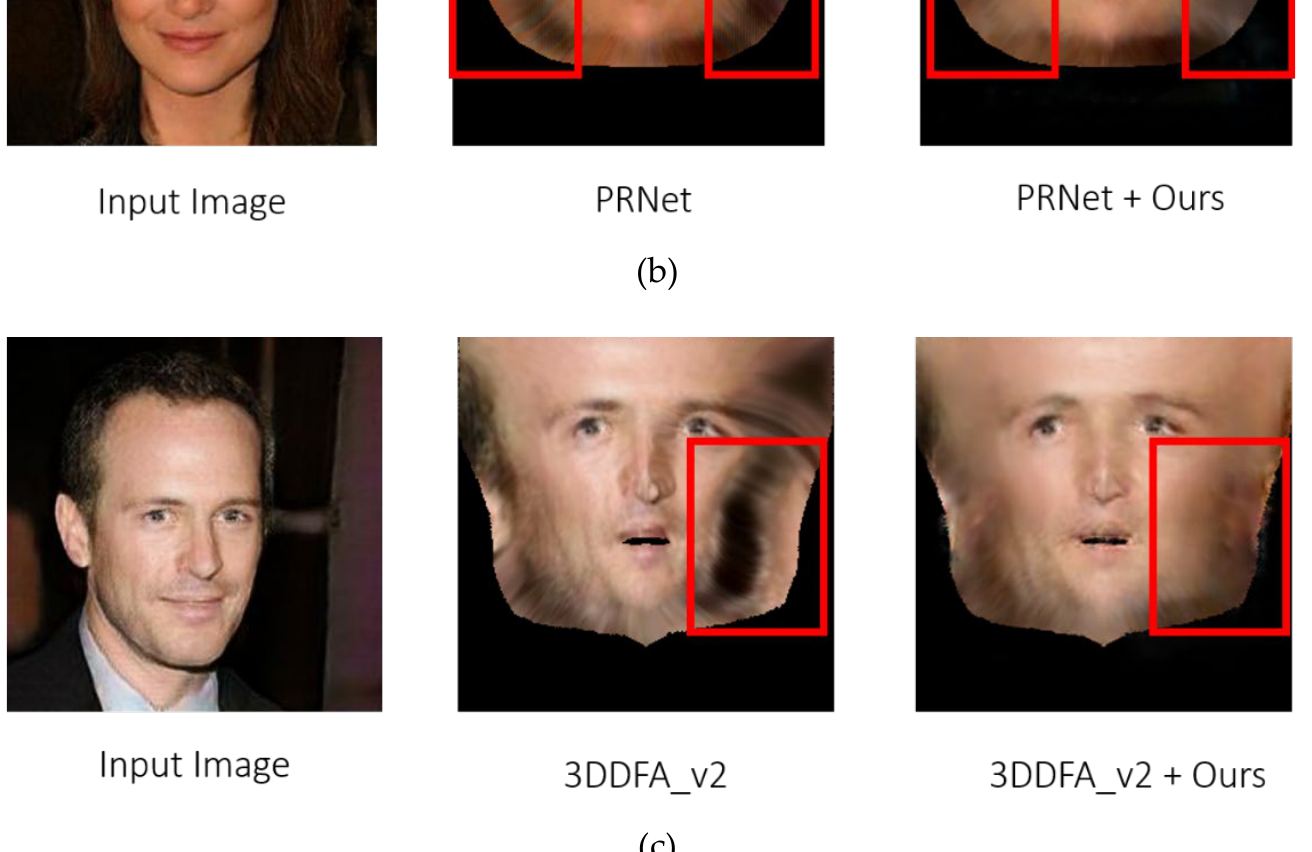
Figure 13. Comparison of the texture generation result.